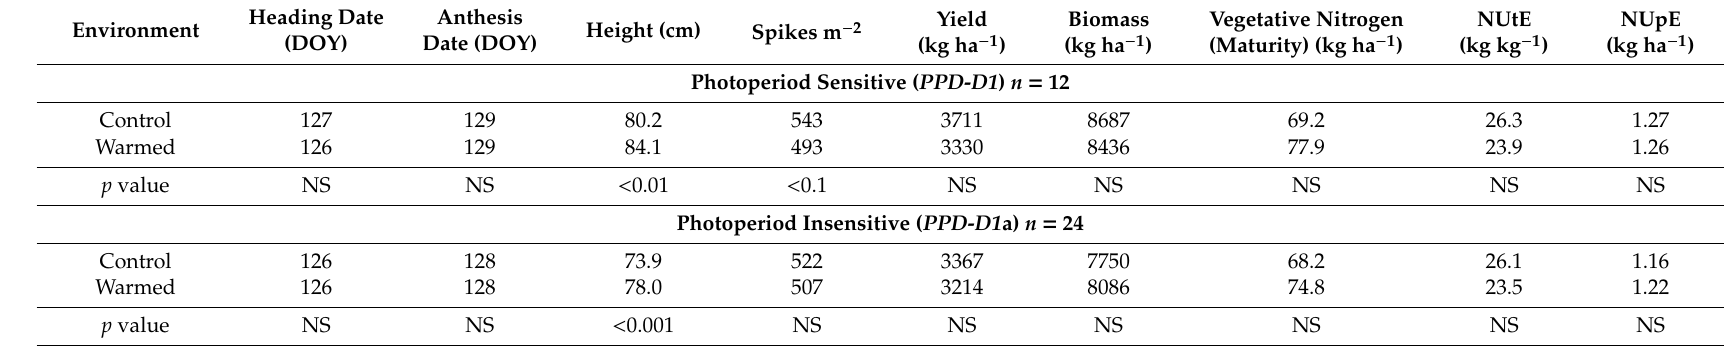
Table 6. Least squares means of agronomic traits † in control and passively warmed environments based on photoperiod classification of 36 soft red winter wheat genotypes, 2015–2016 Lexington,